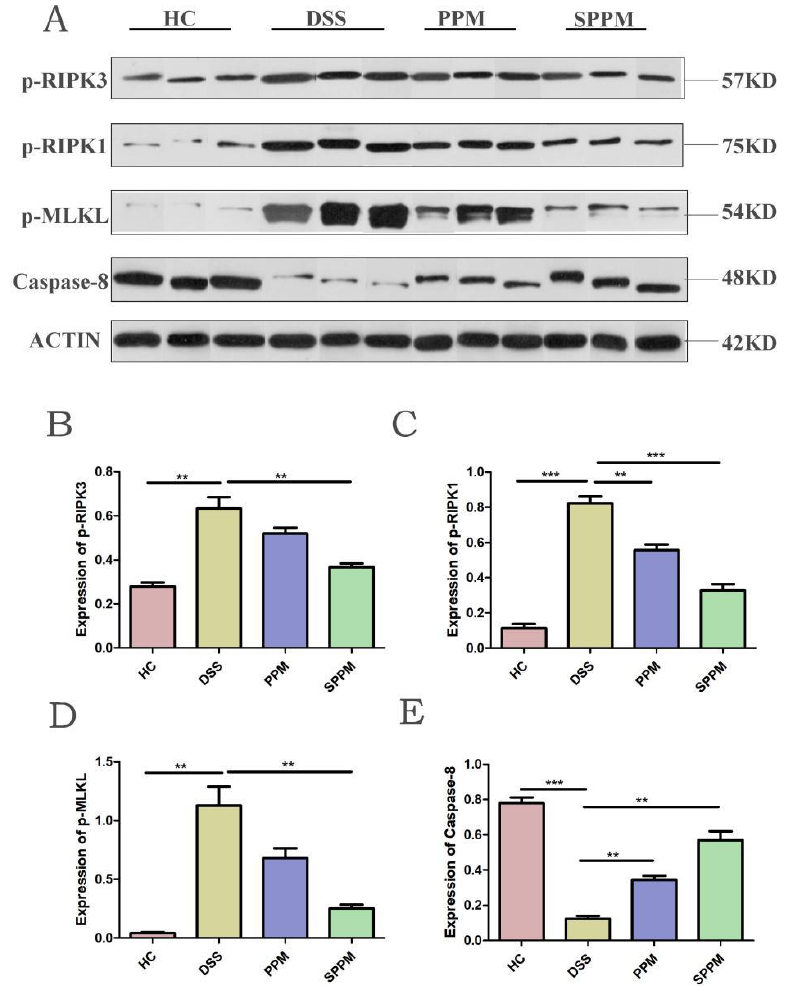
Figure 8. Expression of PPM60-III and SPPM60-III on phosphorylation of proteins associated with necroptosis in mice. ( A ) Protein expression bands of p-RIPK1, p-RIPK3, p-MLKL, and Caspase-8; ( B ) quantitative analysis of p-RIPK3; ( C ) quantitative analysis of p-RIPK1; ( D ) quantitative analysis of p-MLKL; ( E ) quantitative analysis of Caspase-8. ** p < 0.01, *** p < 0.001.